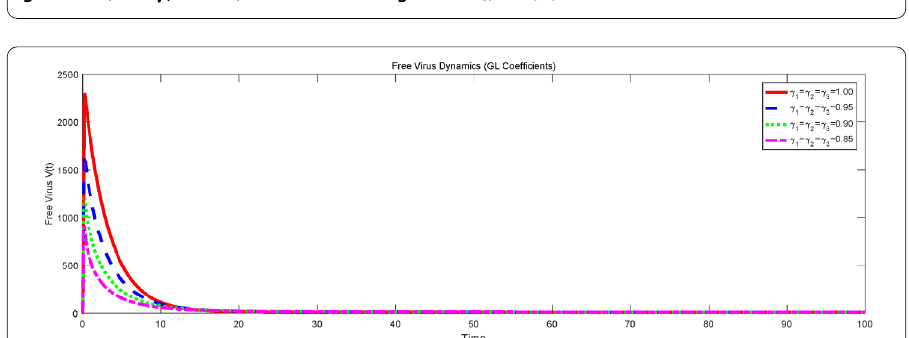
Figure 12 Dynamics of I ( t ) with γ i = 1 (solid red line), γ i = 0.95 (dashed blue line), γ i = 0.9 (dotted green line) and γ i = 0.85 (dotted dashed magenta line), i = 1,2,3.